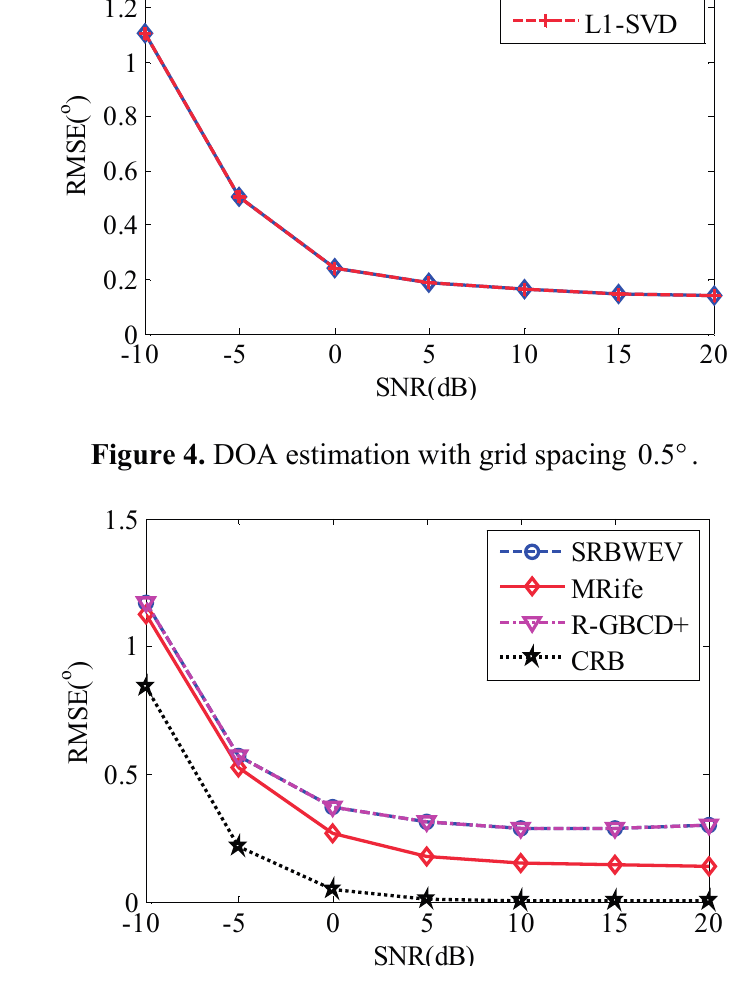
Figure 5. DOA estimation using modified Rife algorithm with grid spacing 1 ° .